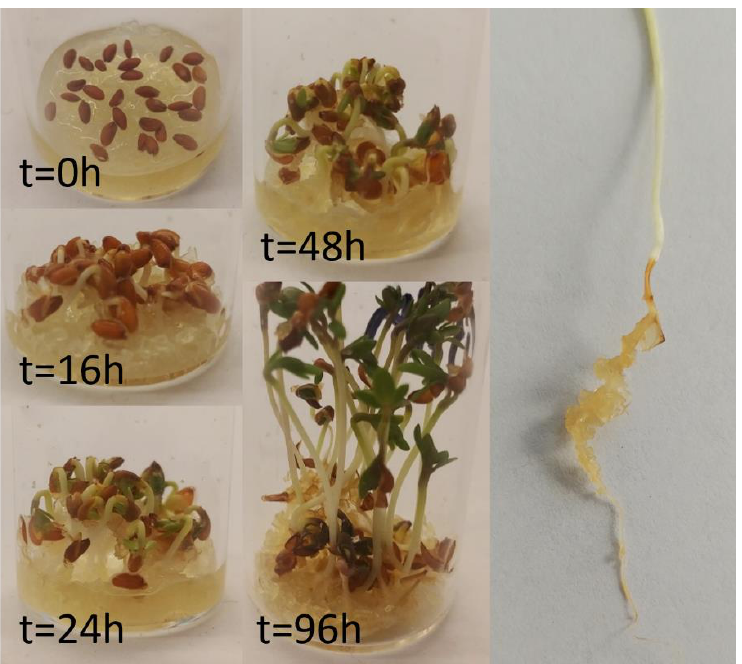
Figure 7. Growing of cress on keratin hydrogel at different time intervals. The picture on the right shows the cress-root which is grown on the keratin gel particles.